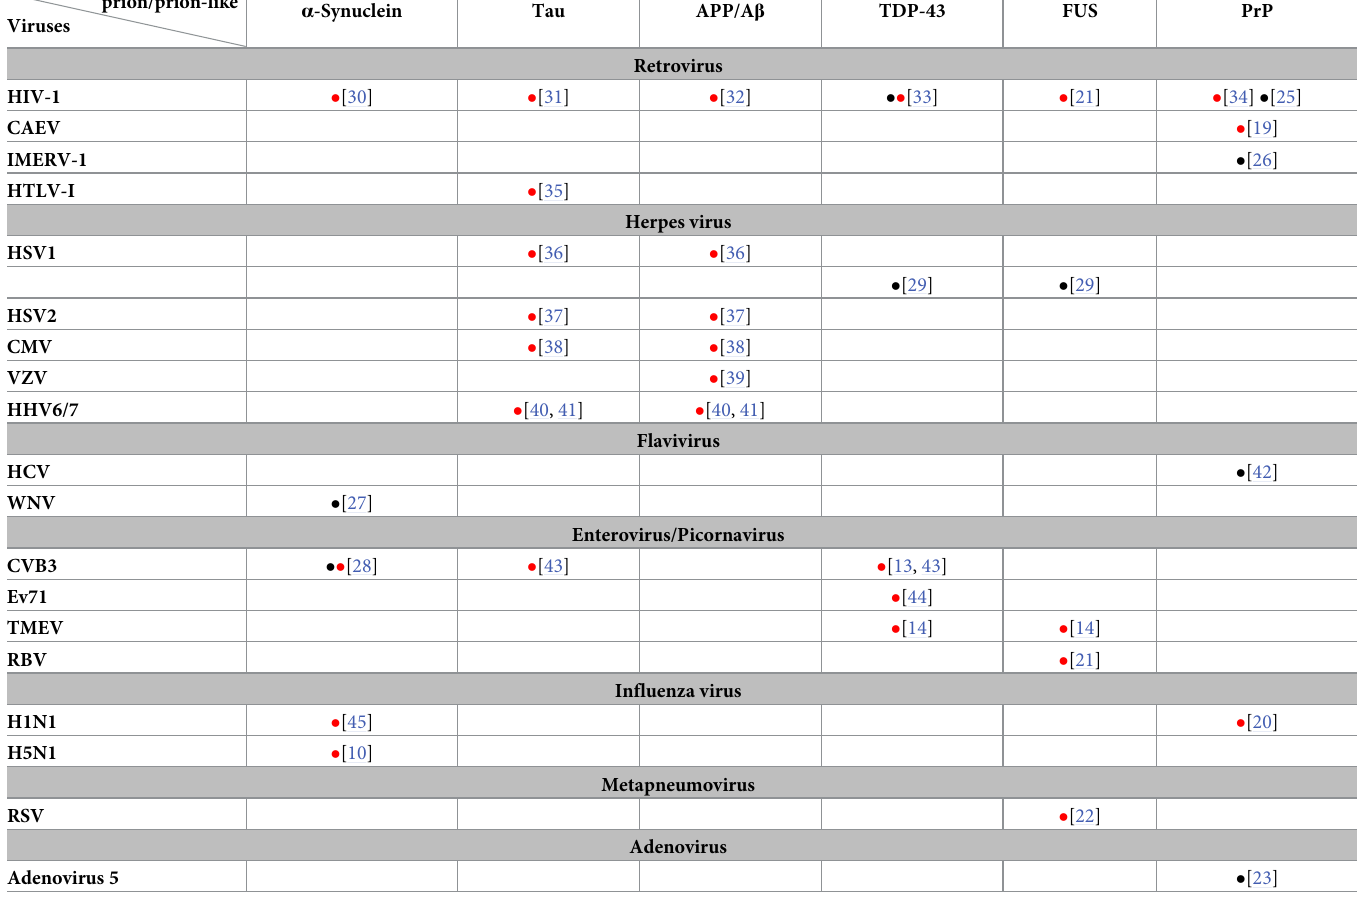
Table 1. Effect of viral infection on the expression and aggregation of ND-associated proteins. prion/prion-like